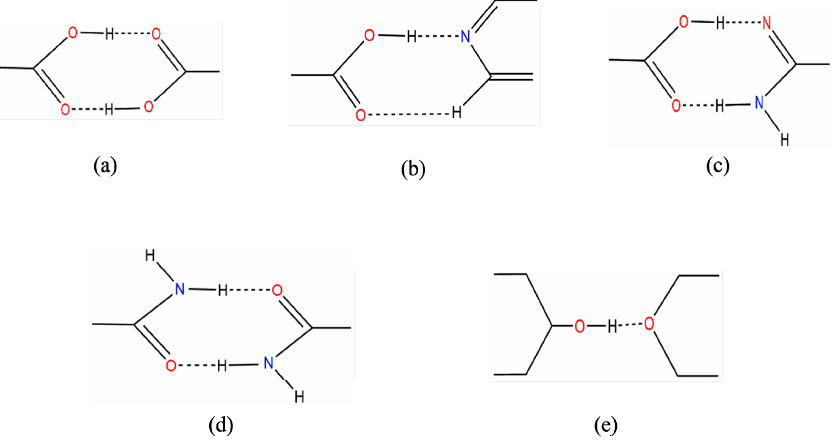
Figure 2. The most common supramolecular synthons in crystal engineering are ( a ) carboxylic acid dimer homosynthon, ( b ) carboxylic acid and pyridine group heterosynthon, ( c ) amide dimer heterosynthon, ( d ) amide group heterosynthons, and ( e ) alcohol and ether group heterosynthons.